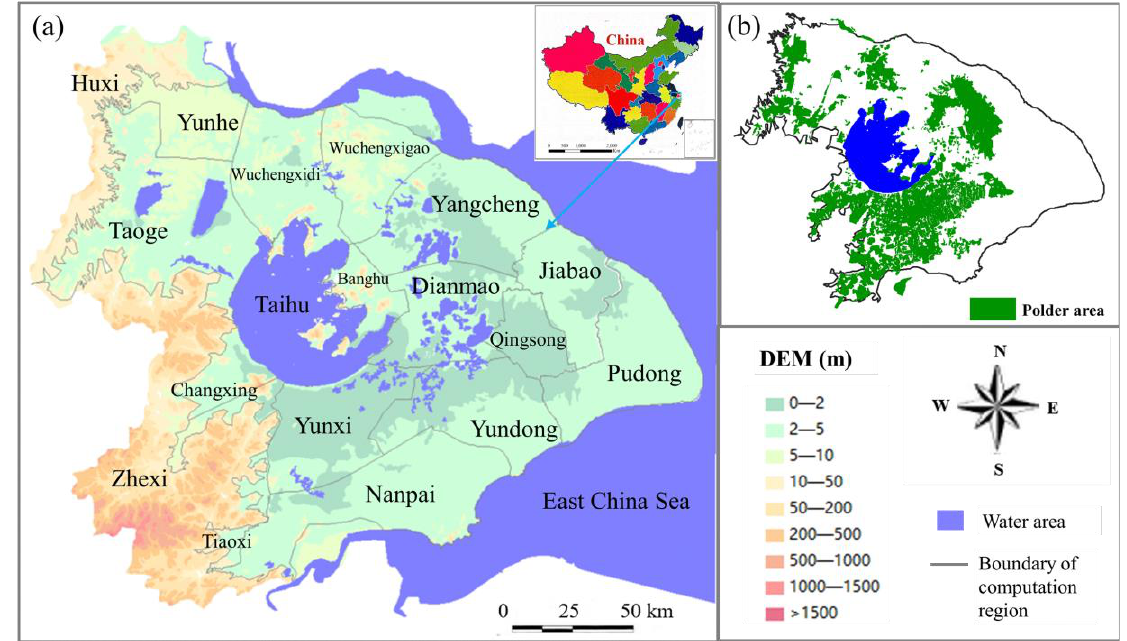
Figure 1. ( a ) Location of Taihu Basin in China and its digital elevation model (DEM); ( b ) the polder area in Taihu Basin.